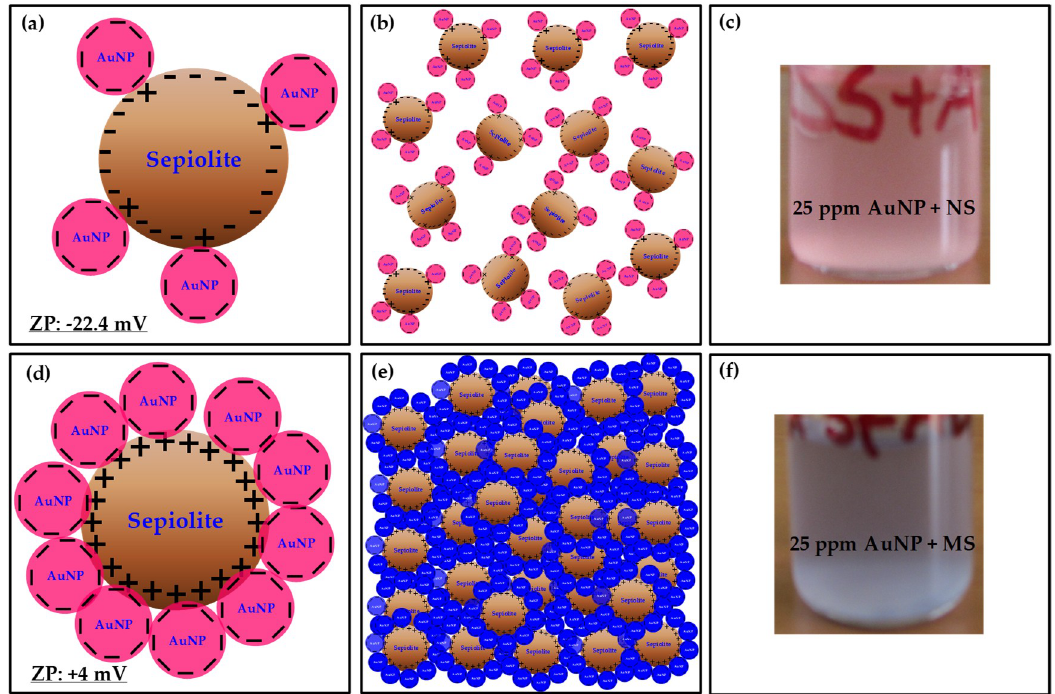
Figure 4. A schematic illustration of the interaction of AuNPs with natural sepiolite (NS) and modified sepiolite (MS). Coating process of AuNPs on NS ( a ) and MS surfaces ( d ). AuNPs–NS particles ( b ) and AuNPs–MS particles ( e ) in the suspension. Pictures of coating of 25 ppm AuNPs on NS ( c ) and MS ( f ) surfaces.